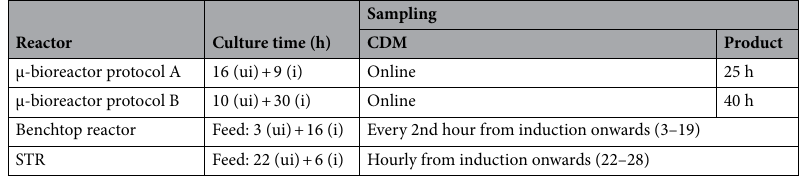
Table 2. Schematic overview of the used reactor systems, culture time (uninduced (ui), induced (i)), and CDM and product sampling timepoints.